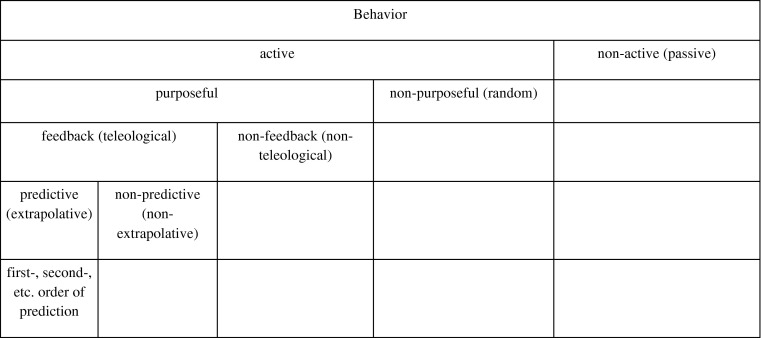
Dichotomous classification of behaviour; after Rosenblueth et al. (1943).